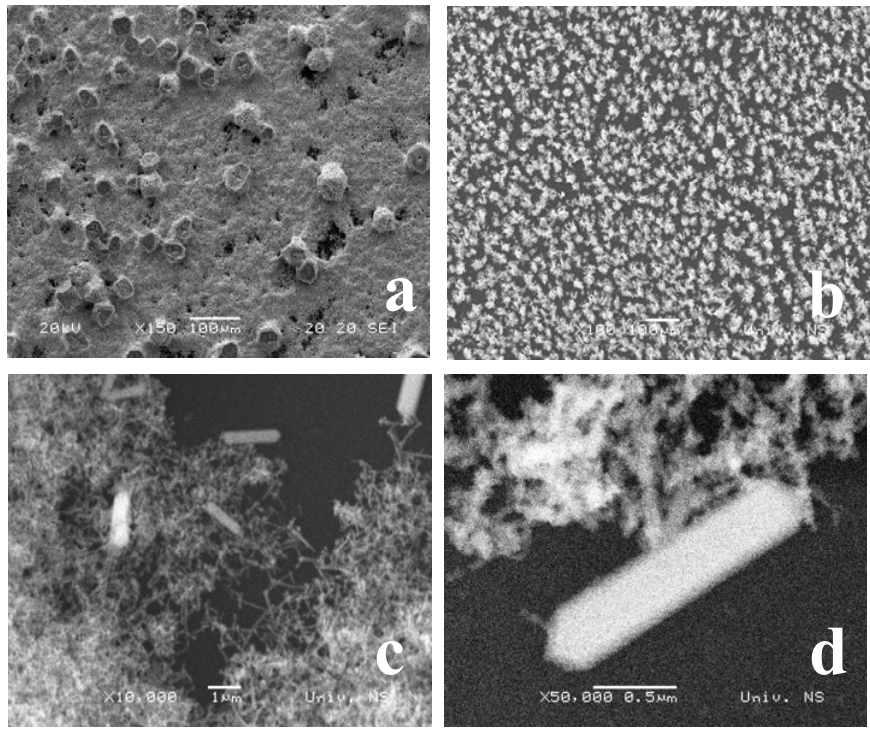
Figure 2. Scanning electron micrographs of bismuth-film deposited on the glassy carbon substrate at − 1.00 V ( a ) and − 0.25 V ( b – d ) for 60